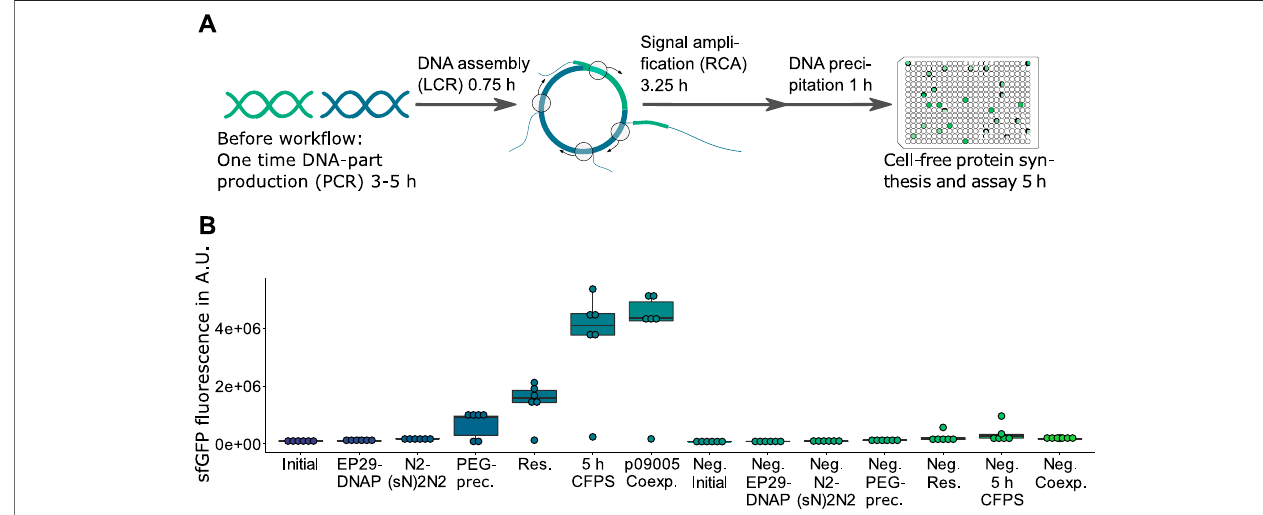
FIGURE 1 | HyperXpress work fl ow and effect on product formation of the most relevant optimizations. (A) The HyperXpress work fl ow starts with the assembly of DNA parts using LCR. This assembly includes a circularization ofthe DNA construct which upon addition of the components required for RCA results in an ampli fi cation ofcircularconstructs.InordertoprovideoptimalreactionconditionsforCFPSabufferexchangeisachievedthroughDNAprecipitationandresuspension.Uponaddition of the components required for CFPS each DNA assembly isassayed for product formation. (B) Results of the sequential optimizations of the work fl ow compared to the corresponding 0 nM bridging oligo reaction as a negative control (Neg.). EP29: EquiPhi29 ™ DNA Polymerase; N2(sN)2N2: endonuclease protected random hexamer oligonucleotides; PEG prec.: in-well DNA precipitation using polyethylenglycol; res.: resuspension of the DNA precipitate in ultrapure water; p09005 coexp.: bicistronic operon plasmid with sfGFP and mKate2 genes used instead of p10024 template with monocistronic GFP reporter construct ( n =